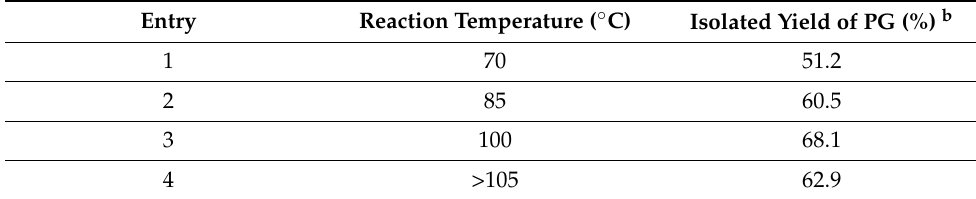
Table 2. Effect of the reaction temperature on the yield of propyl gallate a .